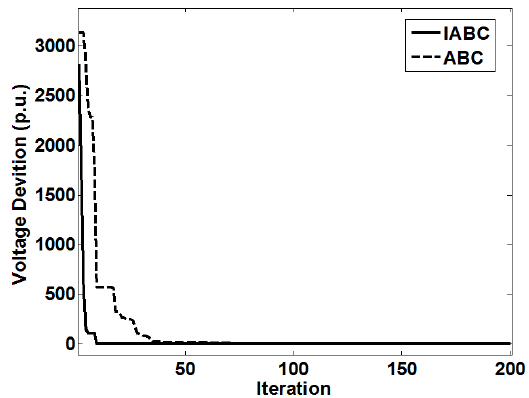
Figure 15. Convergence characteristics of voltage deviation of the IABC and ABC algorithms for the IEEE 57-bus